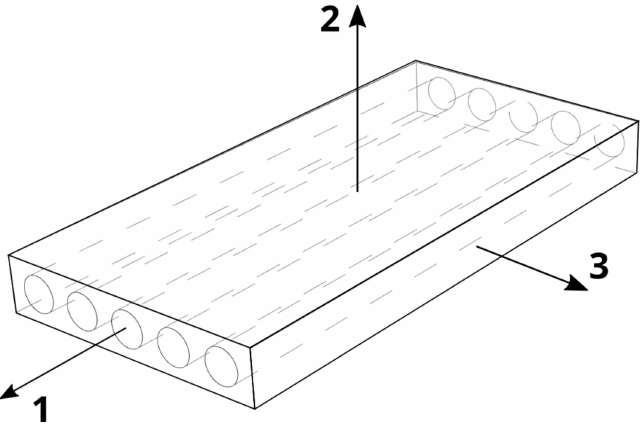
Figure 3. A unidirectional lamina (UD) with a main coordination system 1,2,3 is fixed to the fiber direction (1), laminate (2) and thickness direction